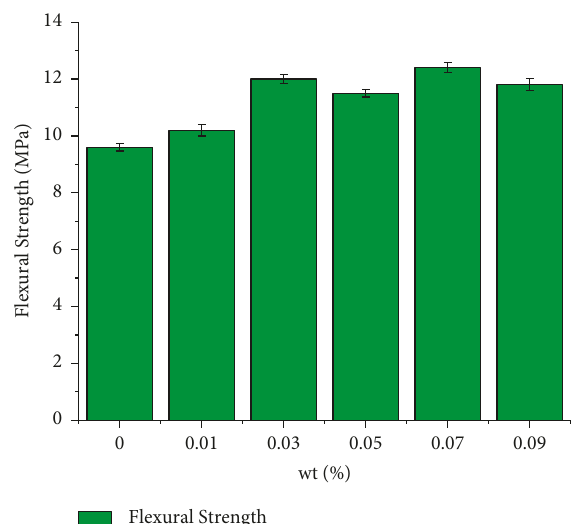
Figure 3: Compressive strength test of ZRJ-S1 reinforced cement- based materials.